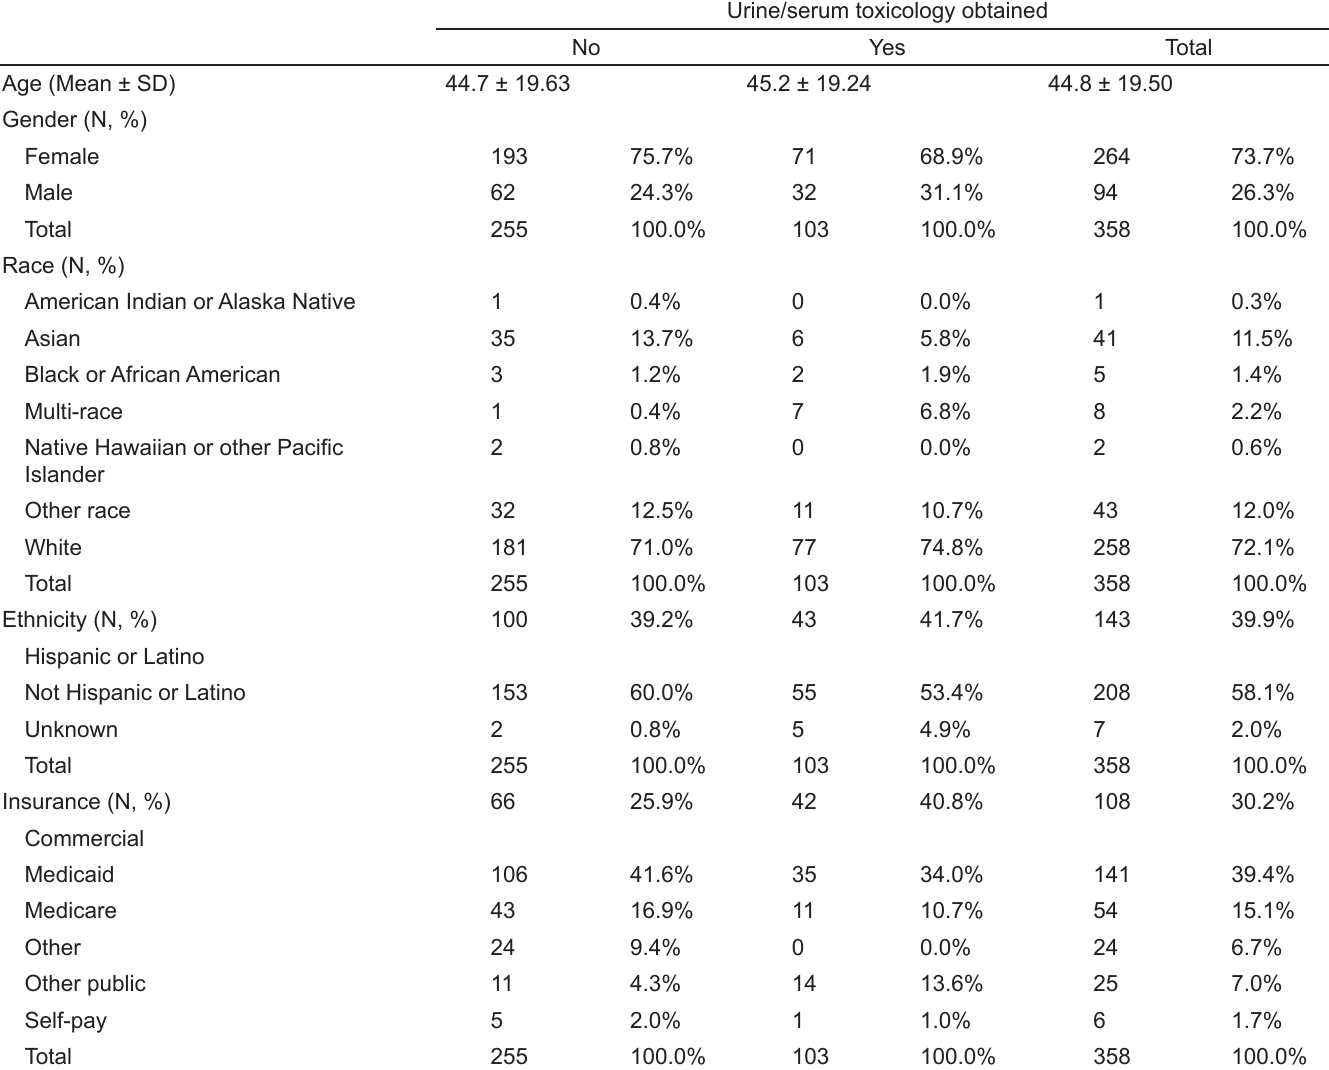
Table 1. Baseline characteristics of patients with a diagnosis of fracture, dislocation, or